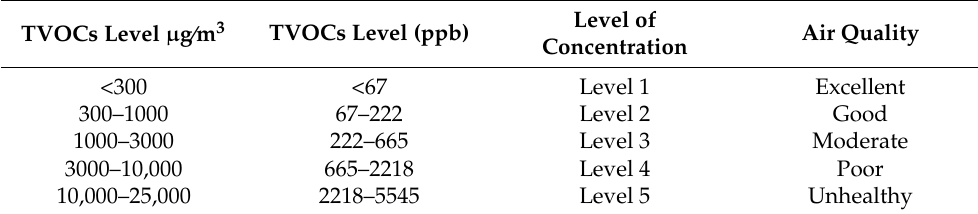
Table 1. TVOCs’ level of concentration